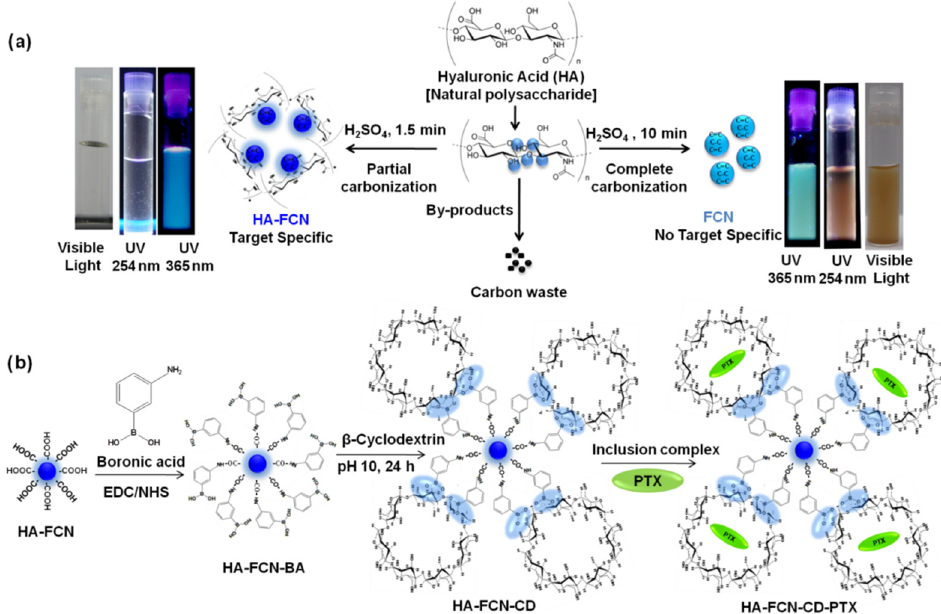
Figure 2. ( a ) Scheme of partial carbonized hyaluronic acid-fluorescent carbon nanoparticle (HA-FCN) and complete carbonized FCN (fluorescent carbon nanoparticle) preparation from hyaluronic acid (HA). An illuminated photograph of aqueous solutions of HA-FCN and FCN under visible light, and 254 nm and 365 nm UV lamps, respectively. Reprinted with permission from ref. [10] Copyright© 2015, The Royal Society of Chemistry. ( b ) The synthesis of Paclitaxel (PTX) complexed HA-FCN-CD [HA-FCN-Cyclodextrin-PTX] for tumor targeted bioimaging guided drug delivery. Reprinted with permission from ref. [47] Copyright© 2015, The Royal Society of